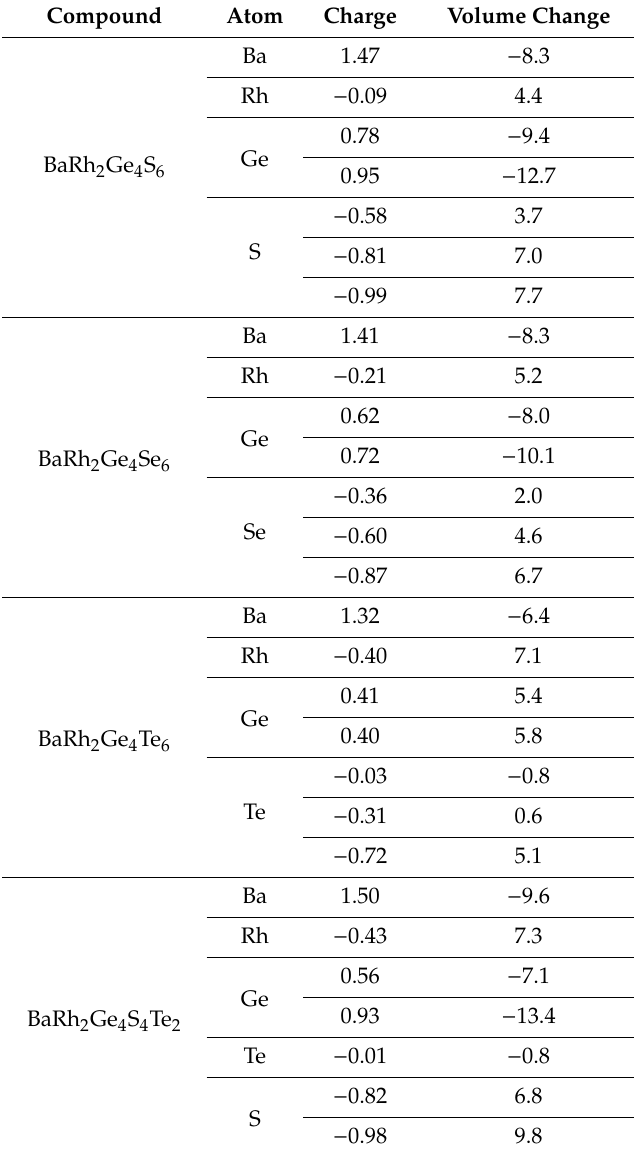
Table 3. Atomic charge (in unit of e) and atomic volume change (in % with respect to the atomic volume obtained from IAM (independent atom model)